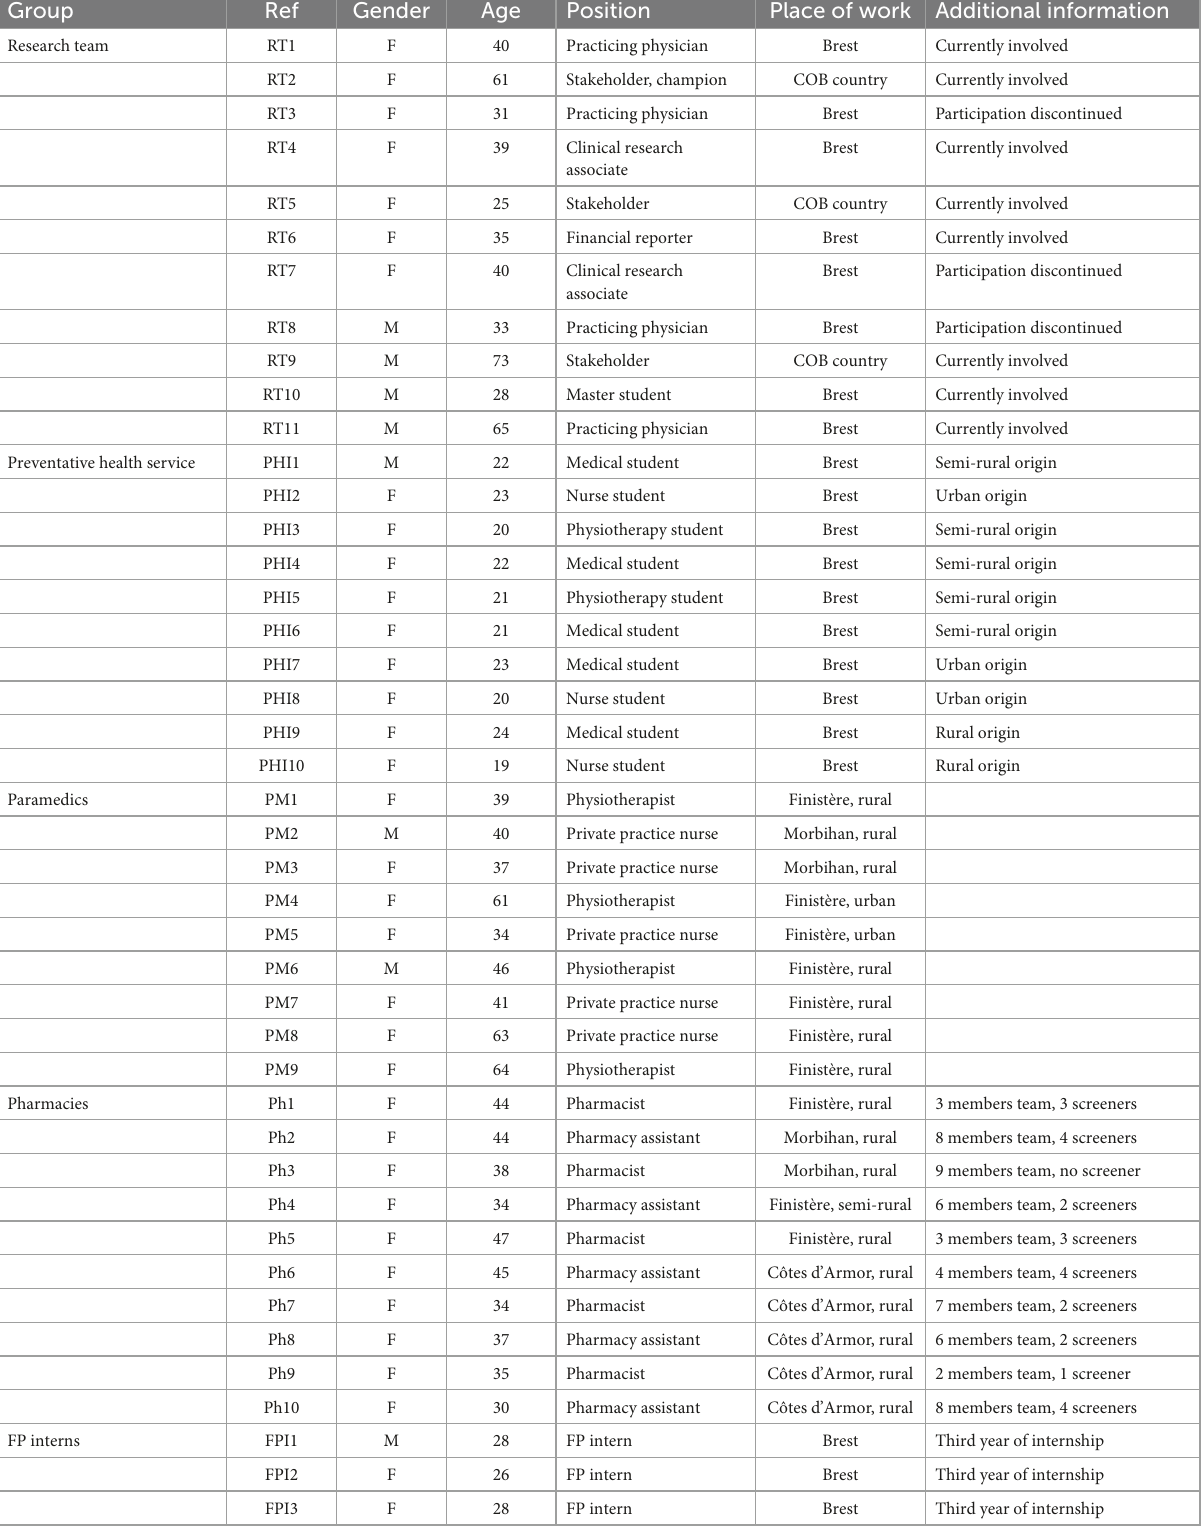
TABLE 2 Sampling characteristics of the qualitative